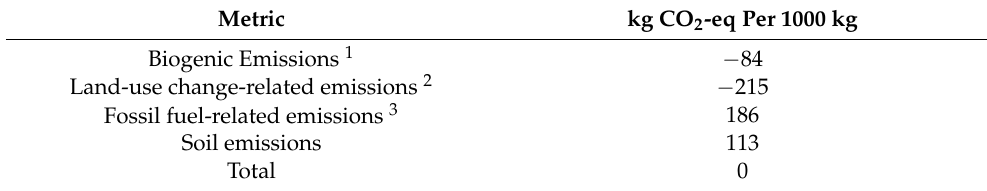
Table 2. GHG emissions (kg CO 2 − eq per 1000 kg grapes) per year for the zero-emissions scenario.